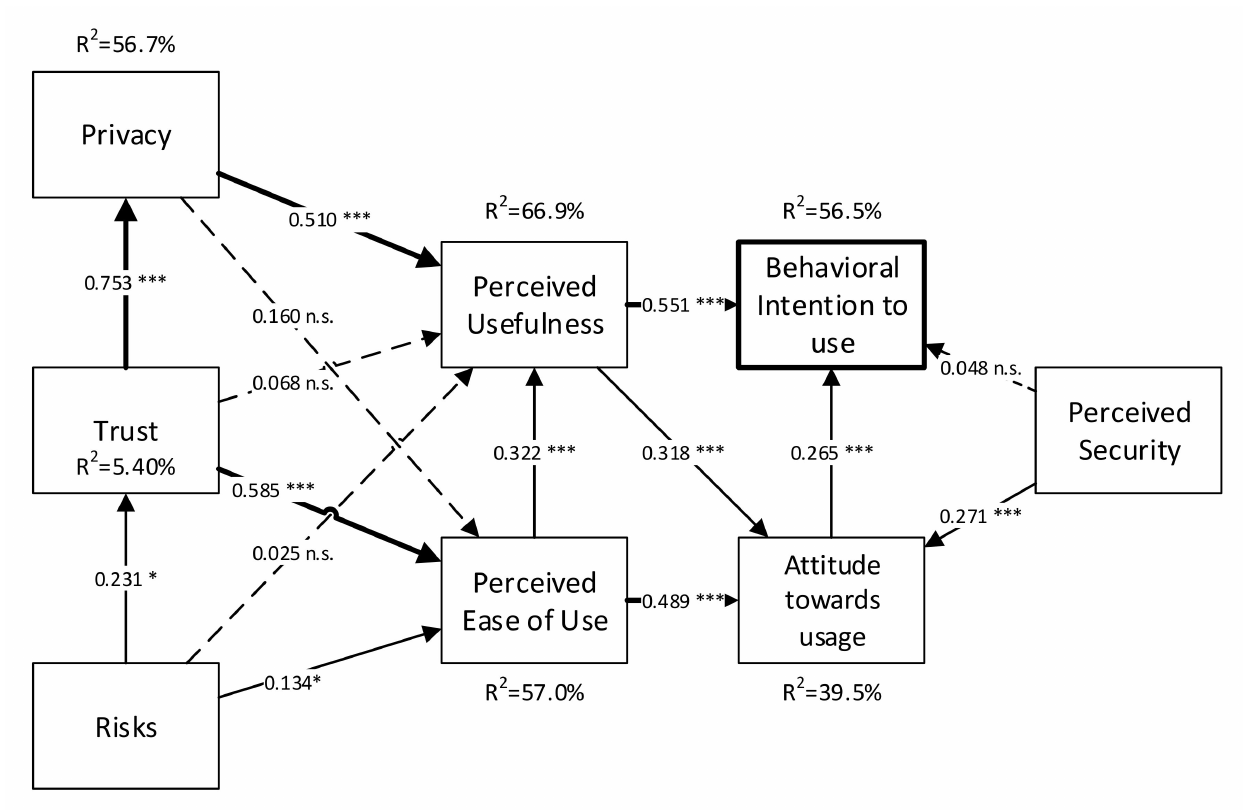
Figure 5. Mediation hypotheses. * p < 0.05; *** p < 0.001; N.S.—not